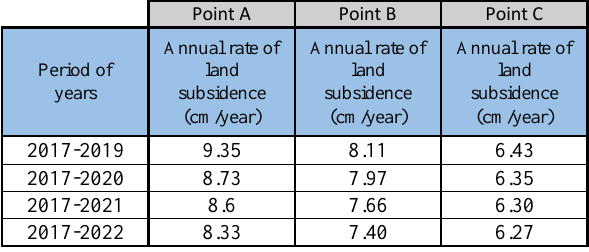
Table 5. Predicted rate of land subsidence at selected points A, B, C assuming a half rate of groundwater